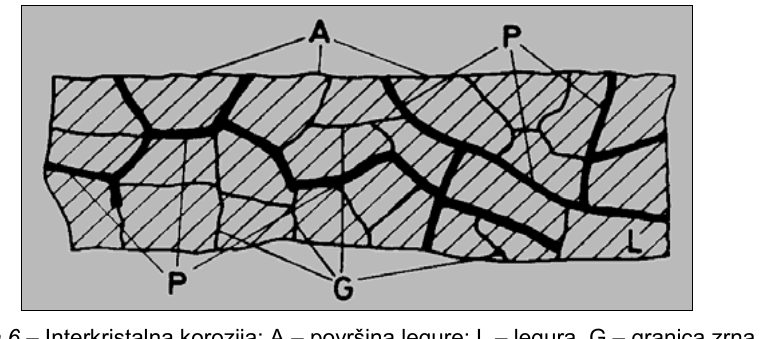
Рис . 6 – Межкристаллитная коррозия : А - поверхность сплава ; L - сплав , G - границы зерен , Р - продукты коррозии на границах зерен . Figure 6 – Intergranular corrosion: A - surface of alloy; L – alloy, G – grain boundaries, P - products of corrosion at the grain